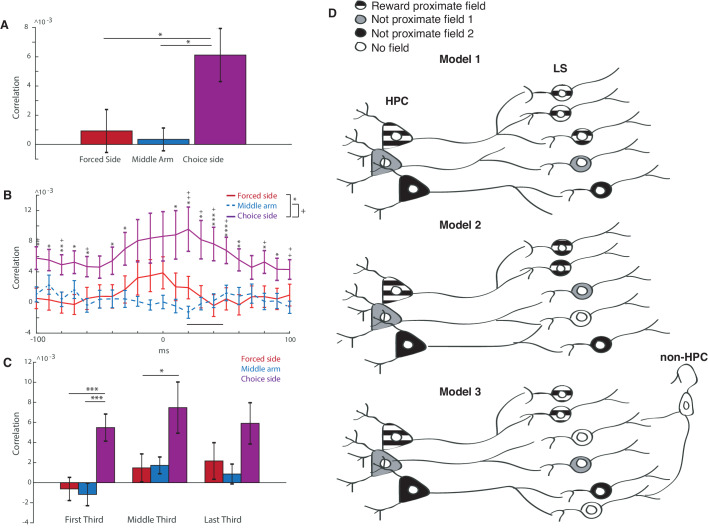
Reward proximate LS cells are more synced with hippocampal activity than not proximate cells.(A) Averaged cross correlation across a lag of −100 to 100 ms between coupled pairs of HPC and LS cells, based on place field location. Error bars show standard error. Forced side versus choice side: two-tailed two sample t-test t(67)=-2.2, p<0.05, middle arm versus choice side: two-tailed two sample t-test t(54)=-2.3, p<0.05). (B) Average of cross correlation traces at all lags between coupled pairs of HPC and LS cells, based on place field location. Error bars show standard error. Mean correlation peak for forced arm correlations was at 20 ms. Results from unpaired two tailed t-tests between forced and choice arms are indicated with stars: * indicates a p value of < 0.05 on an unpaired two tailed t-test, ** indicates a p value of < 0.01, and *** indicates a p value of < 0.005. Analogous results are shown between choice arm and middle arm using +. (C) Differences in cross correlations for HPC-LS pairs during the first, middle, and last third of a single trial. Error bars show standard error. * indicates a p value of < 0.05 on an unpaired two tailed t-test, *** indicates a p value of < 0.005. (D) Three models of LS innervation by HPC that may explain the overrepresentation of LS place fields by rewarded locations. Top: model 1. HPC cells with reward-proximate place fields selectively innervate more LS place cells. Middle: model 2. HPC cells with reward proximate place fields, and cells with other fields innervate the same number of LS cells. Hippocampal cells with non-proximate fields innervate overlapping cells, causing interference and resulting in fewer place fields in the LS that are not reward proximate. Bottom: model 3. HPC cells with reward proximate place fields, and cells with other fields innervate the same number of LS cells. Hippocampal cells with non-proximate fields innervate cells that are also innervated by other inputs, causing interference and resulting in fewer place fields in the LS that are not reward proximate.